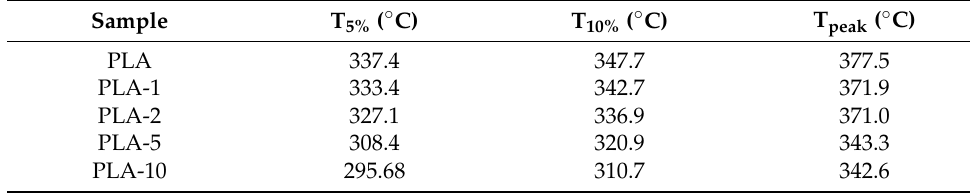
Table 6. Thermogravimetric analysis (TGA) of PLA and blends.